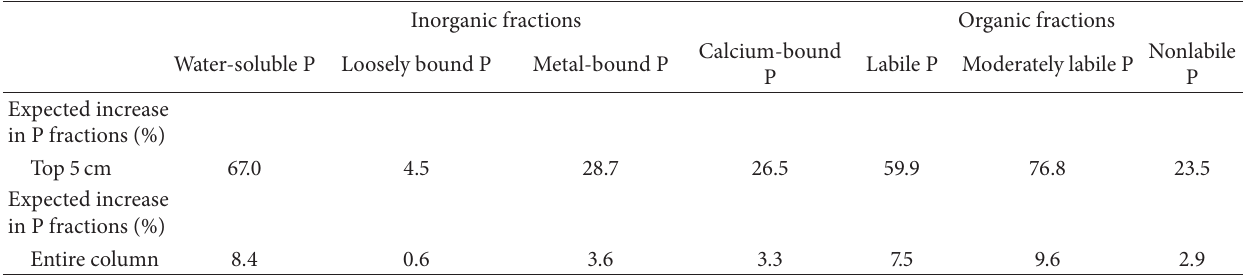
Table 2: Quantitative phosphorus concentration increases expected in the entire length of the soil columns within 1 week from biosolids